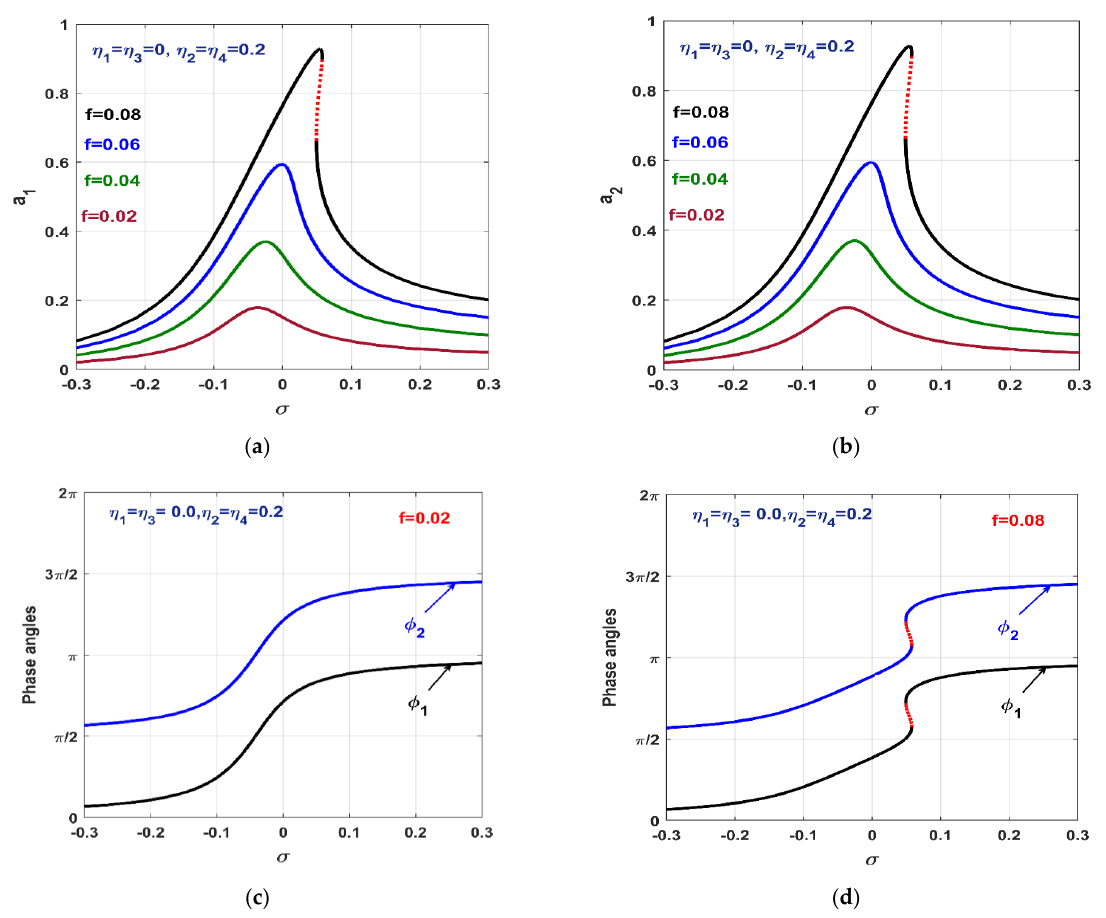
Figure 5. Vibration amplitudes of the twelve-poles rotor in the case of the PD + IRC -control algorithm when f = 0.02, 0.04, 0.06, and 0.08: ( a , b ) vibration amplitudes ( a 1 , a 2 ) of the rotor, ( c ) phase angles ( 𝜙 (cid:2869) ,𝜙 (cid:2870) ) when 𝑓 = 0.02 , and ( d ) phase angles when 𝑓 = 0.08 .